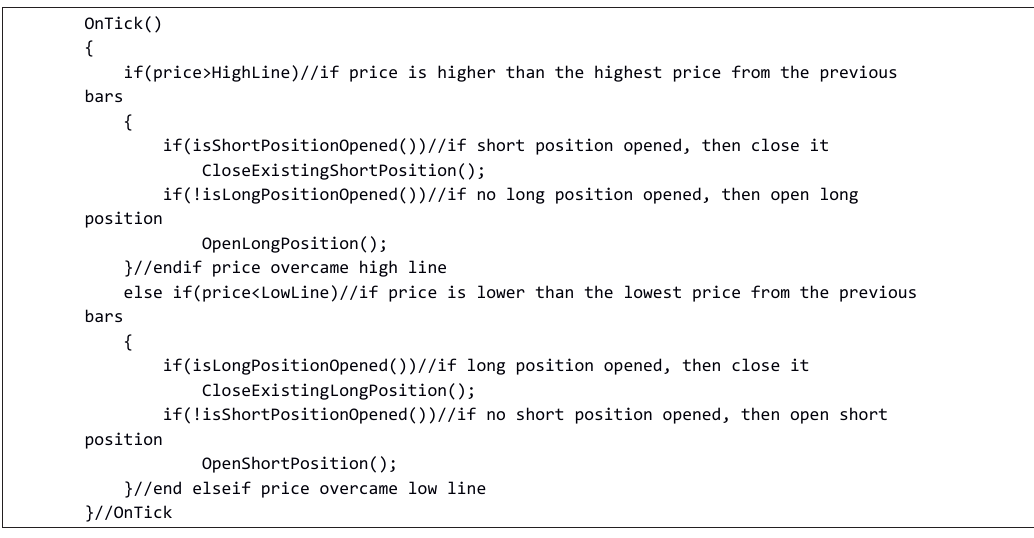
Figure 1. The rules for executing